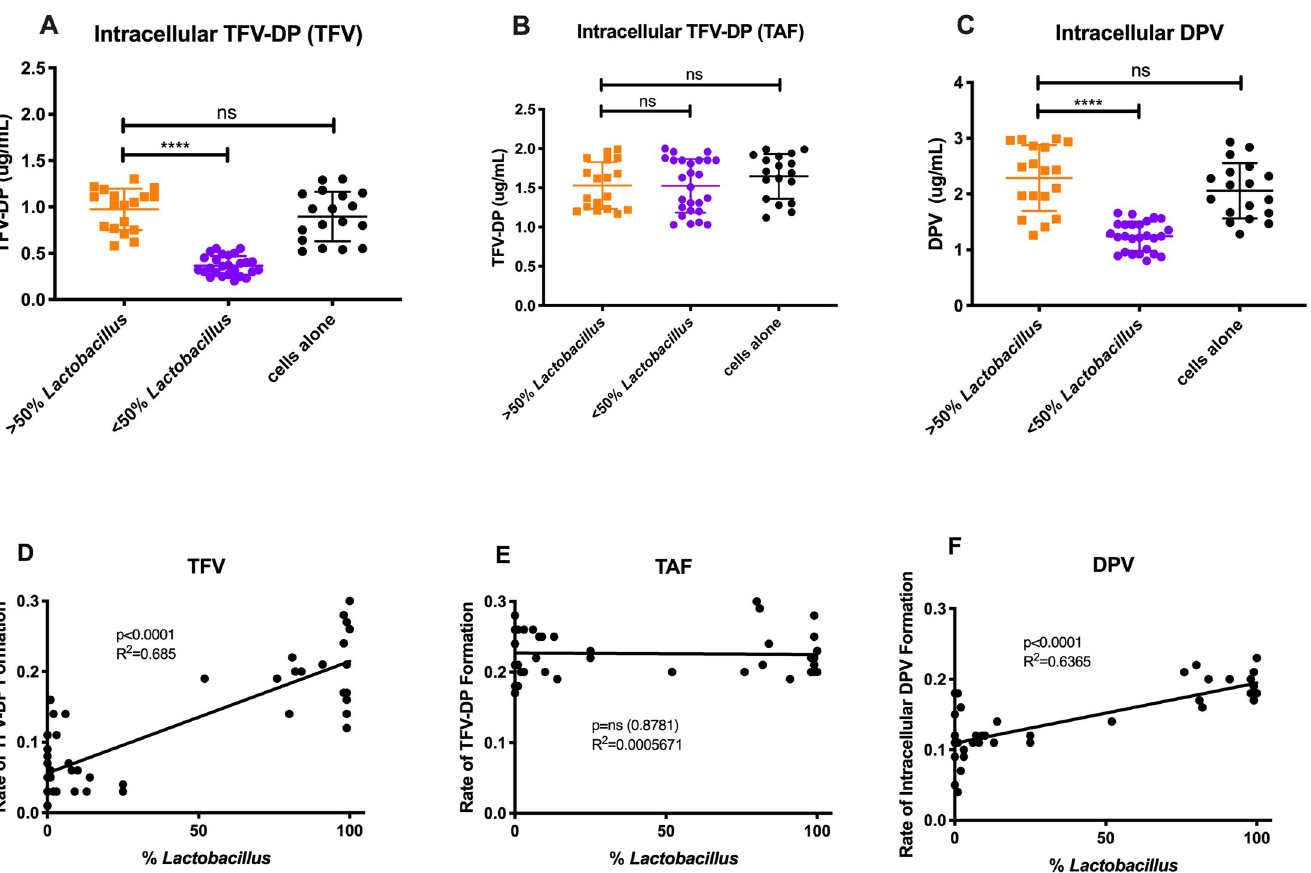
Fig 5. Intracellular active metabolite formation after 24 hours grouped by Lactobacillus dominance or non-dominance. (A) Amount of intracellular TFV-DP formed post-TFV administration after 24 hours at 37C in Lactobacillus dominant versus non- Lactobacillus dominant CVLs. Orange, greater than 50% dominance; Purple, less than 50% dominance. (B) Amount of intracellular TFV-DP formed post-TAF administration after 24 hours at 37C in Lactobacillus dominant versus non- Lactobacillus dominant CVLs. Orange, greater than 50% dominance; Purple, less than 50% dominance. (C) Amount of intracellular DPV formed post-DPV administration after 24 hours at 37C in Lactobacillus dominant versus non- Lactobacillus dominant CVLs. Orange, greater than 50% dominance; Purple, less than 50% dominance. (D) Rate of TFV-DP formation (amount/hour) vs. % Lactobacillus in CVLs after 24-hour incubation with TFV. Rate of degradation calculated as amount formed/24 hours. (E) Rate of TFV-DP formation (amount/hour) vs. % Lactobacillus in CVLs after 24-hour incubation with TAF. Rate of degradation calculated as amount formed/24 hours. (F) Rate of DPV formation (amount/hour) vs. % Lactobacillus in CVLs after 24-hour incubation with DPV. Rate of degradation calculated as amount formed/24 hours.